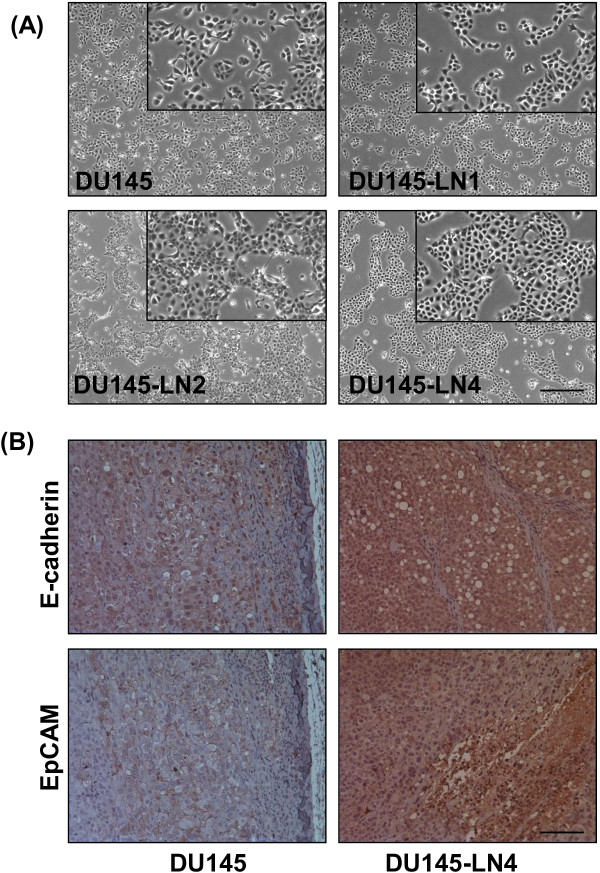
Phenotype of DU145-LN cells with increased metastatic ability. (A) Phase contrast microscopy images of parental DU145 cells, DU145-LN1, DU145-LN2, and DU145-LN4 cells. Cells exhibit progressive phenotypic changes after selection, with increased clustering and cell-cell adhesions from parental DU145 (top left panel) to DU145-LN4 (bottom right panel). Insets are larger images of lower panels. Scale bar = 0.5 mm (B) DU145-LN4 tumor cells maintain their mesenchymal-epithelial transition (MET) phenotype in vivo. IHC of DU145 and DU145-LN4 subcutaneous tumor tissue with the epithelial markers, E-cadherin and EpCAM. High expression of E-cadherin and EpCAM was maintained in the tumor tissue. Scale bar = 100 μm.